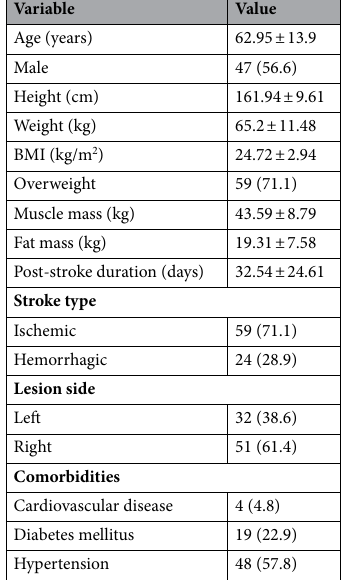
Table 1. Demographic and disease-related characteristics of the subjects ( N = 83). Values represent mean ± standard deviation (SD) or number (%). N, number, BMI, body mass